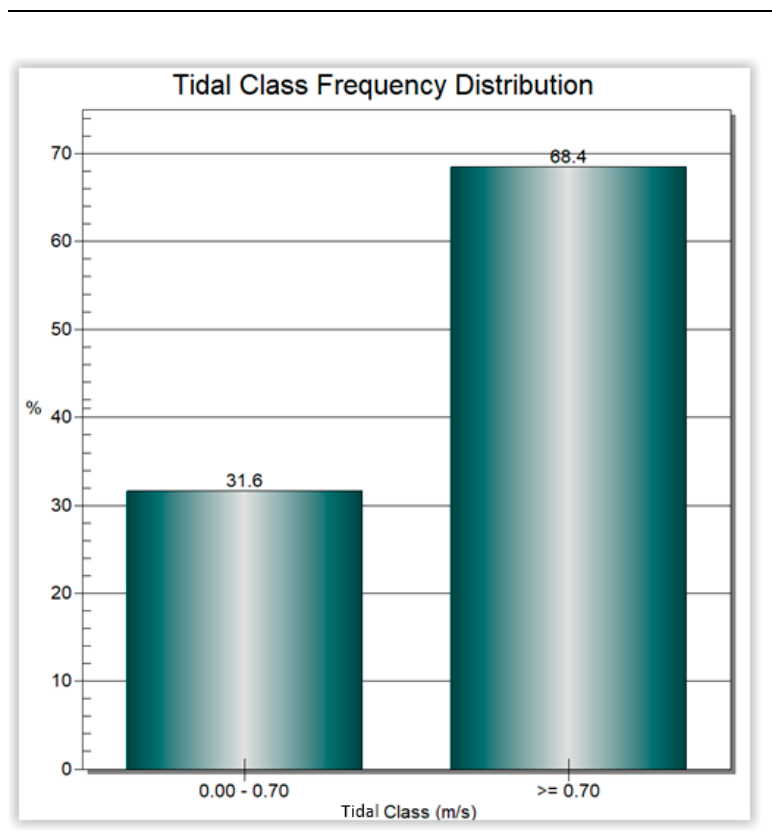
Figure 11. Tidal speed frequency distribution at Foveaux site.